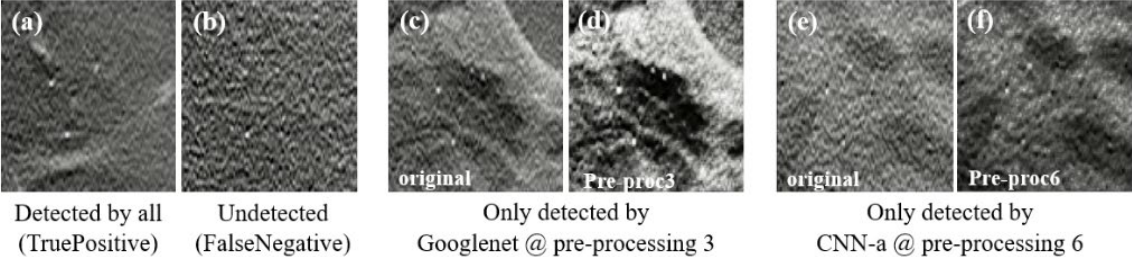
Figure 9. Some examples of MCs in the DBT data used. ( a ) True positive (case correctly classified as positive by all CNNs, even in the original image); ( b ) false negative (case incorrectly classified as negative by all CNNs, even when varying the preprocessing); ( c ) original case classified as negative and that was only detected by GoogLeNet when preprocessed with method 3 ( d ); ( e ) original case classified as negative that was only detected by CNN-a when preprocessed with method 6 ( f ).